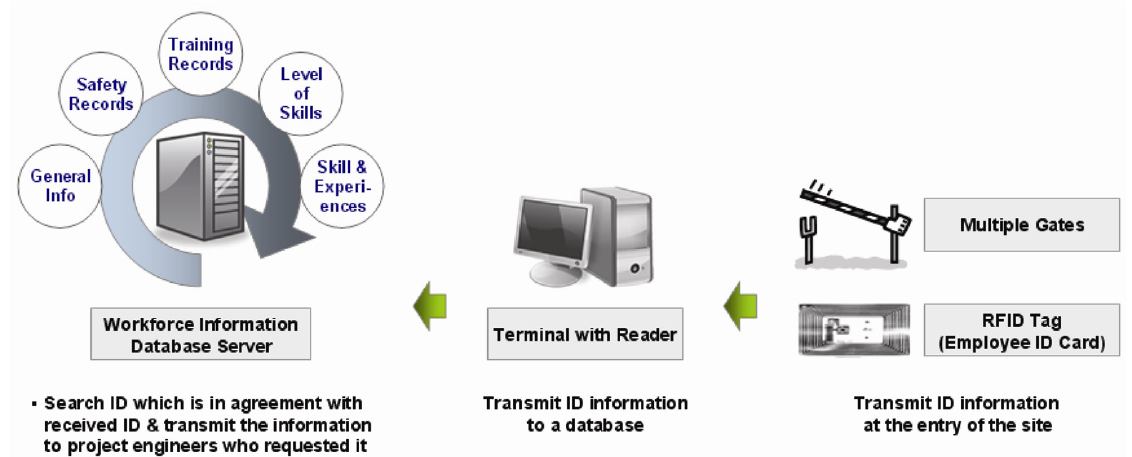
Fig. 8. System architecture for RFID